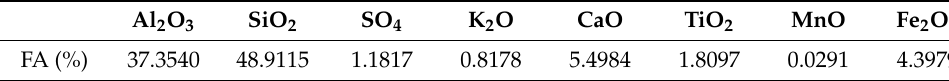
Table 2. Chemical properties of fly ash.